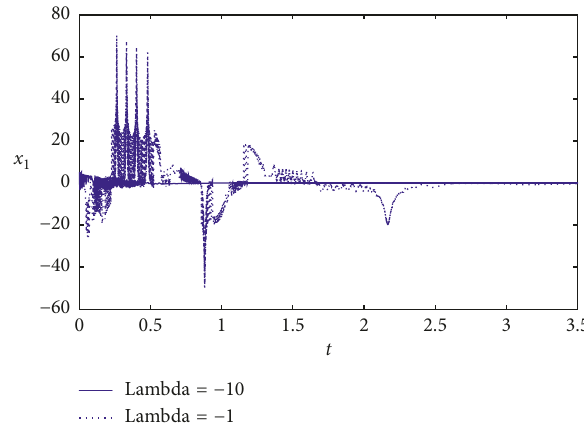
1 of system (29) with